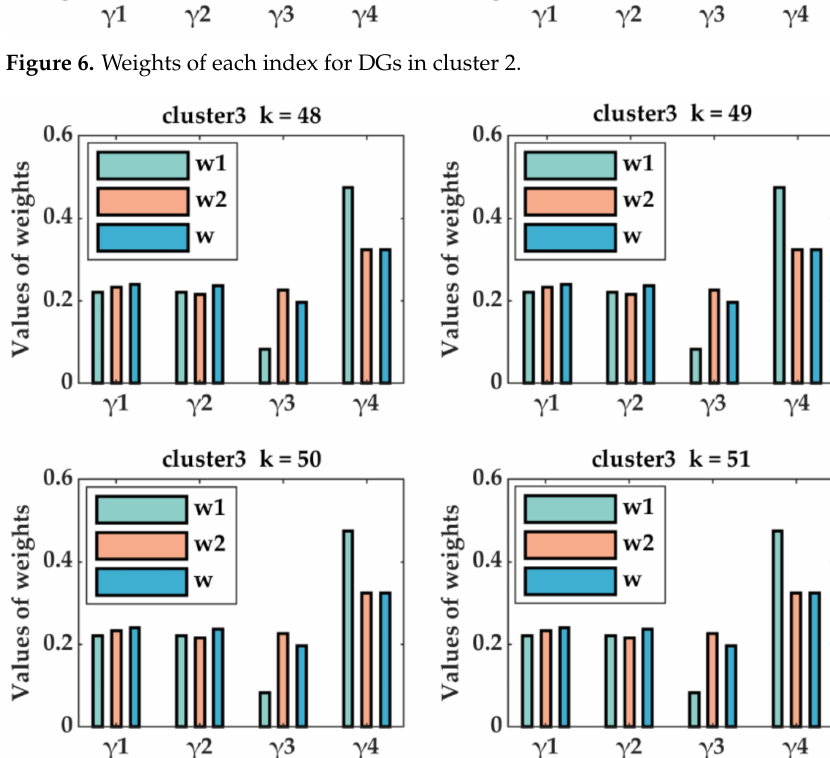
Figure 7. Weights of each index for DGs in cluster